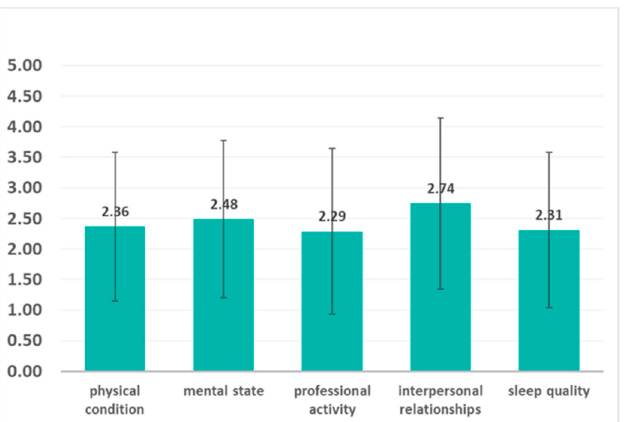
Figure 3. The impact of the pandemic on functionality. Using 5-point Likert scales (1 means not at all, and 5 means completely affected), functioning was evaluated in five areas. Interpersonal relationships (mean = 2.74, SD = 1.40) and mental state (mean = 2.48, SD = 1.28) were the most affected by the pandemic, followed by impaired physical condition (mean = 2.36, SD = 1.21), sleep quality (mean = 2.31, SD = 1.26), and professional/academic activities (mean = 2.29, SD = 1.36).